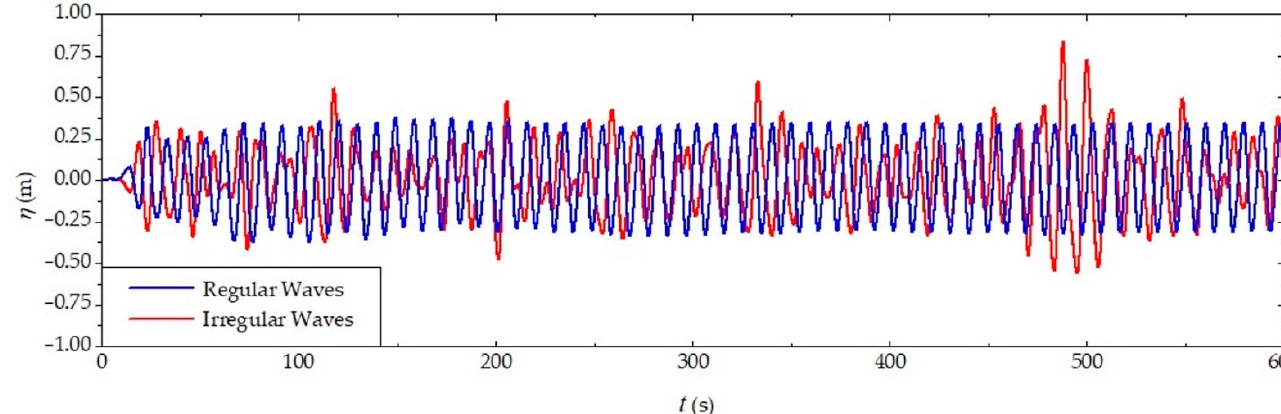
Figure 10. Free-surface elevation obtained with representative regular waves and realistic irregular waves for RG.